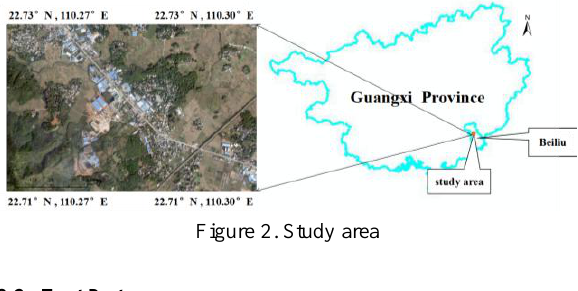
Figure 2. Study area